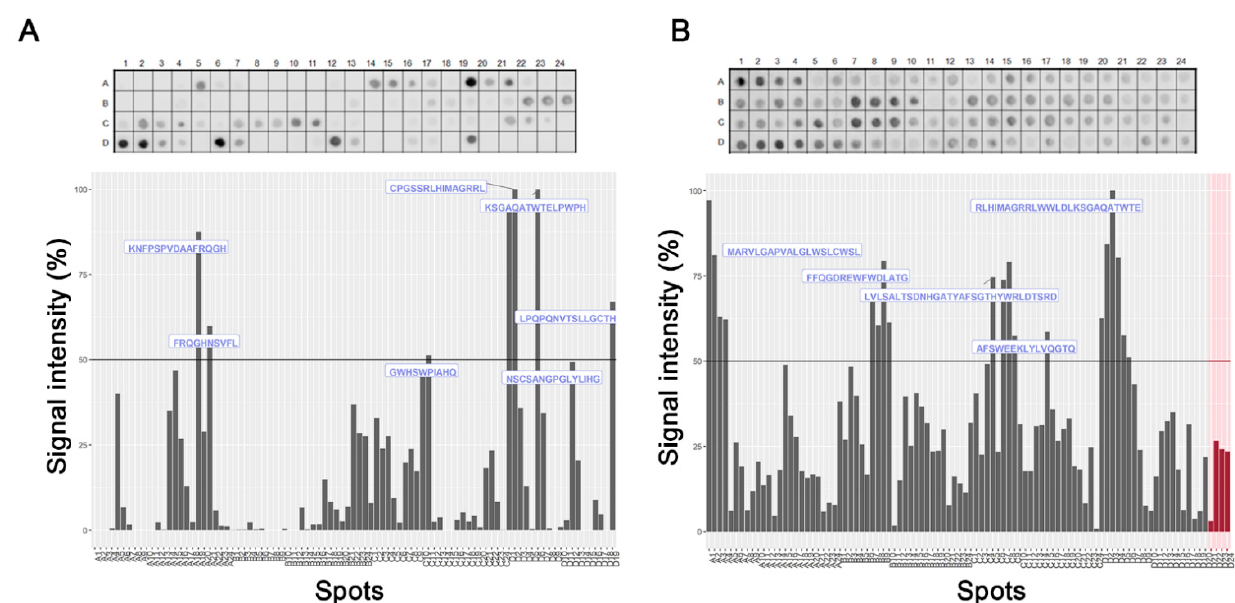
Figure 1. Linear mapping of hemopexin interaction with hemin and hemoglobin in the SPOT syn- thesis array (15 residues, 10 overlaps). ( A ) The signal intensity of interaction regions of hemopexin sequences with hemin; ( B ) The signal intensity of hemoglobin binding to hemopexin. The negative controls (red bars) represent sequences of 60 kDa chaperonin from Leptospira interrogans (DREKLQERLAKLAG), Toxoplasma gondii —dense granule protein GRA6 (HPGSVNEFDF), rabies virus (AVNFPNPPGKGGG), and cowpox virus (QEVRKYFCV). Each peptide was identified by spot-synthesis membrane position numbering (Table S1). Spot intensities below 50% were considered as background. Table 1. List of the identified interactions between hemopexin and hemin/hemoglobin and the structural properties of these regions.